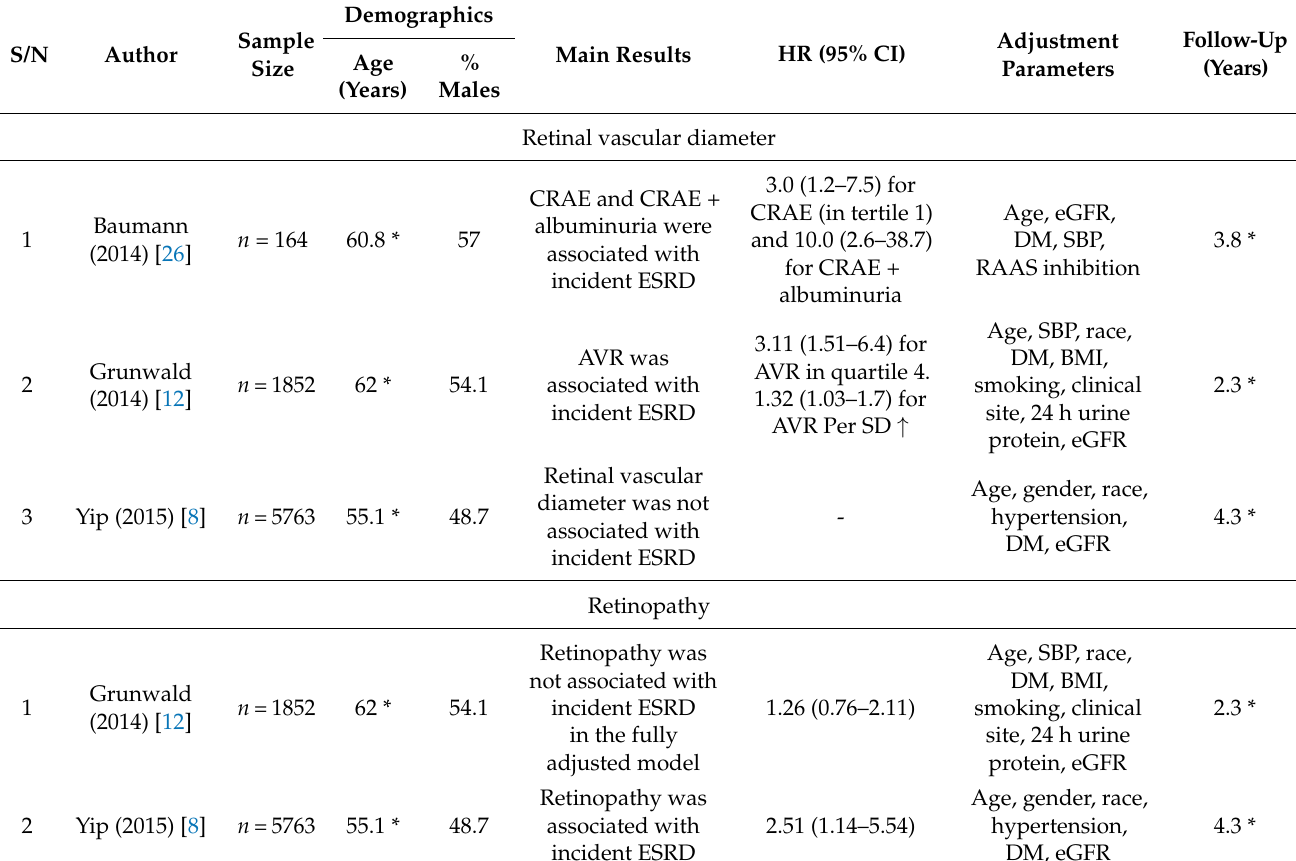
Table 2. Retinal microvascular signs and incident ESRD.